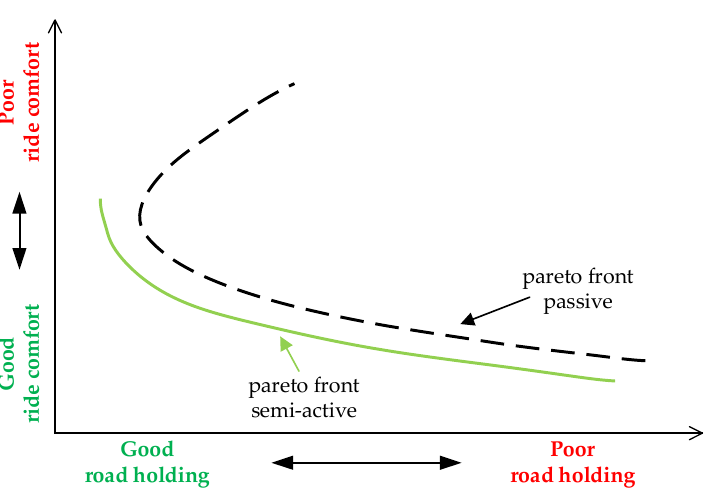
Figure 1. Diagram with a trade-off between comfort and road holding and its optimal Pareto front (adapted from [13]).